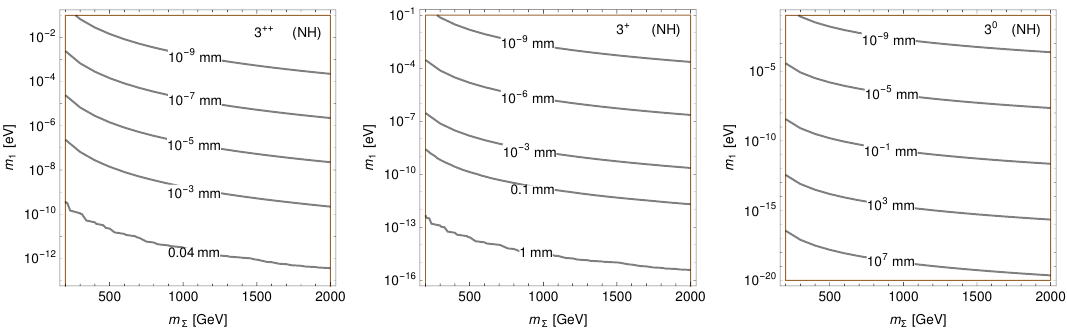
Figure 13 . Contour plots for decay length in ( m 1 − m Σ ) plane for 3 ++ , 3 + and 3 0 , respectively, for normal hierarchical light neutrino mass